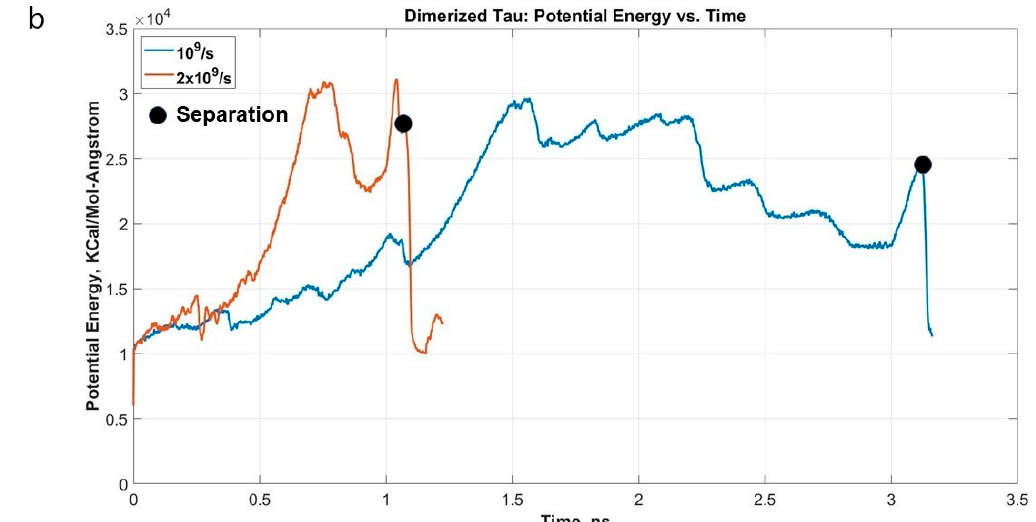
Figure 3. ( a ) Stress-strain plot of protein 2 projection domain for two different strain rates. At a lower strain rate, we observe the development of stress at a higher value and delayed separation, and vice versa. ( b ) Potential energy vs. time plot for the system.